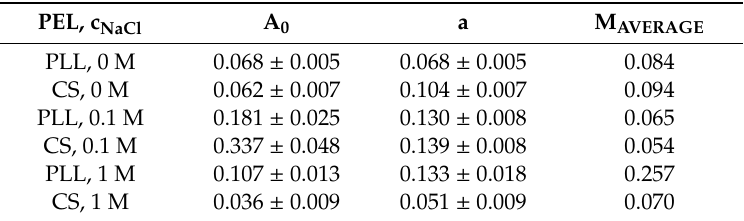
Table 2. Growth parameters A 0 and a for individual PLL and CS deposition profiles obtained from fitting the data given in Figure 2 and mean modulation amplitude M AVERAGE .